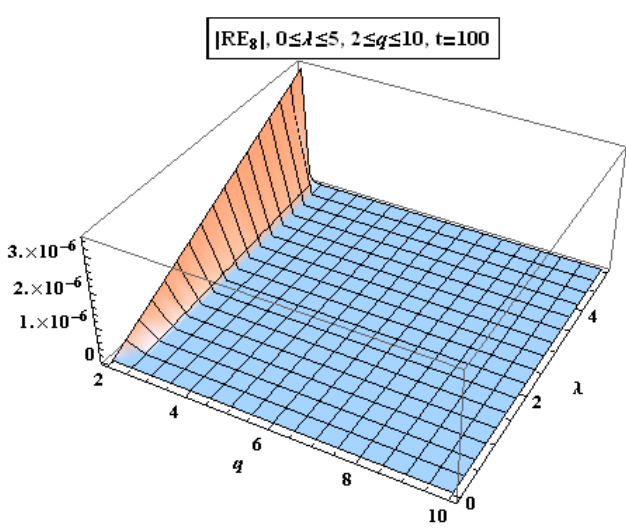
Figure 9. Residual at α = 0.8, 2 ≤ q ≤ 10, 0 ≤ λ ≤ 5, t =